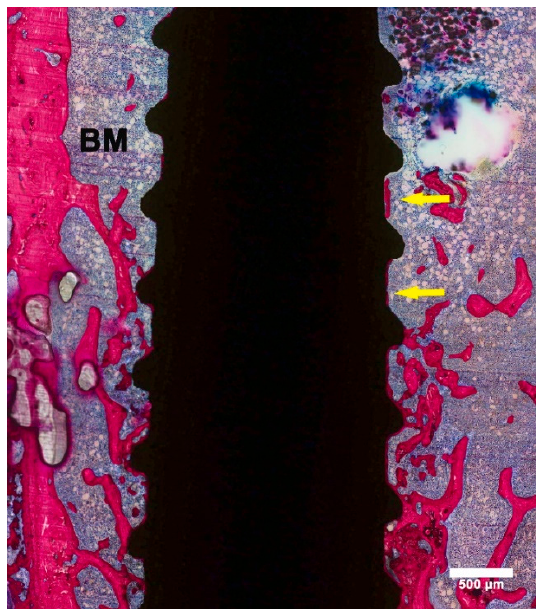
Figure 5. Light micrograph of a specimen of the ZOL-Post study group. Trabecular bone appears in contact with the implant surface, and a thin layer of bone covers part of the implant surface (yellow arrows).